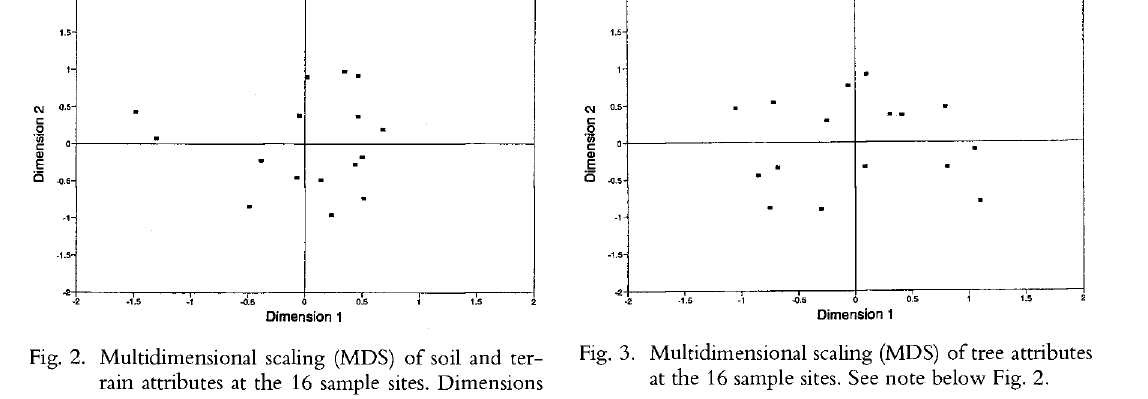
Fig. 2. Multidimensional scaling (MDS) of soil and ter rain attributes at the 16 sample sites. Dimensions 1 and 2 represent combinations of attribute scores which account for the largest and the next largest amount of variation among the sites.